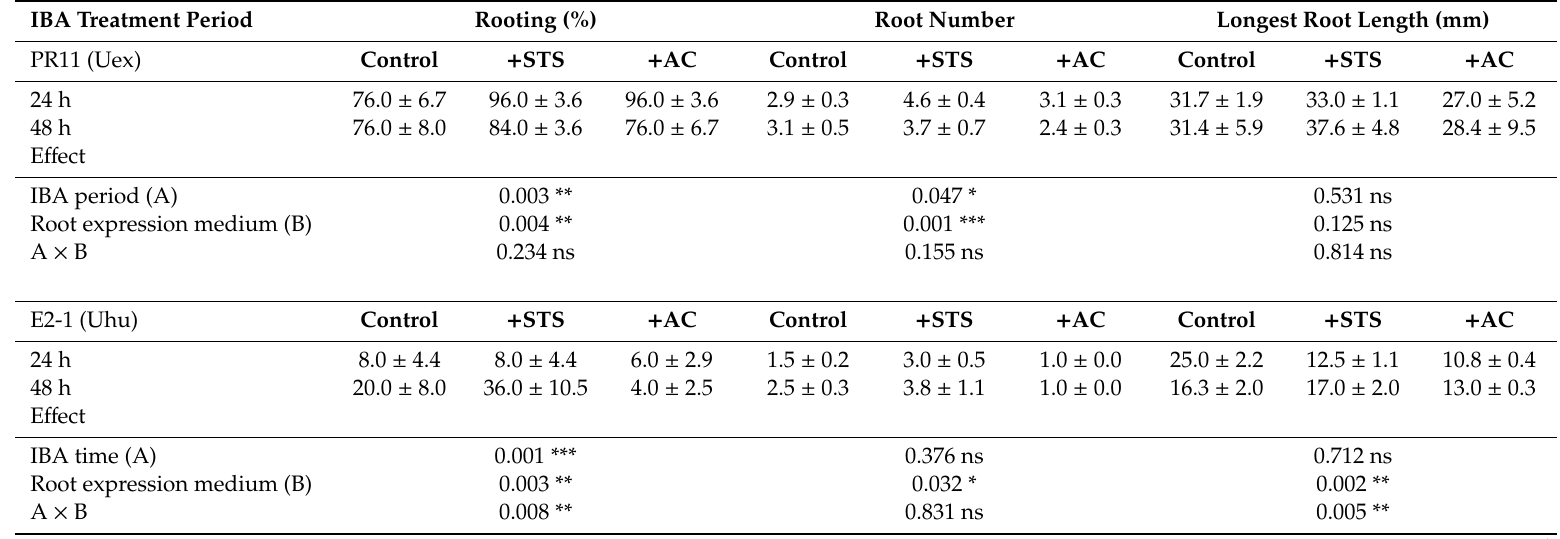
Table 4. E ff ect of indol-3-butiric acid (IBA) treatment period and the addition of 20 µ M silver tiosulphate (STS) or 0.4% activated charcoal (AC) on the rooting ability of shoots from two tolerant Quercus ilex